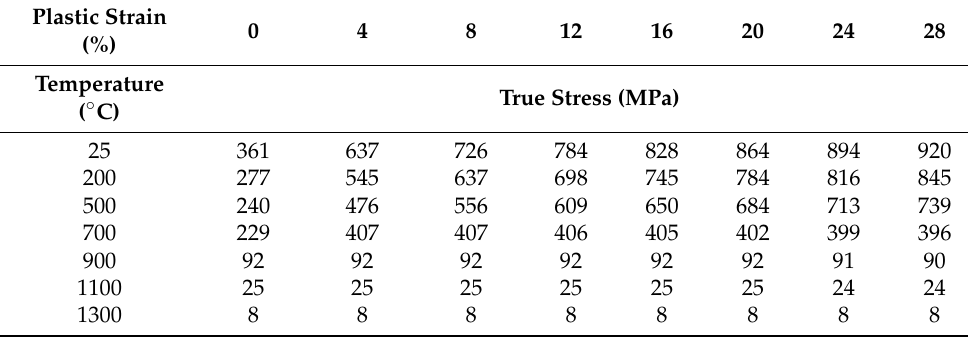
Table 15. Flow stress of INCONEL52M at different